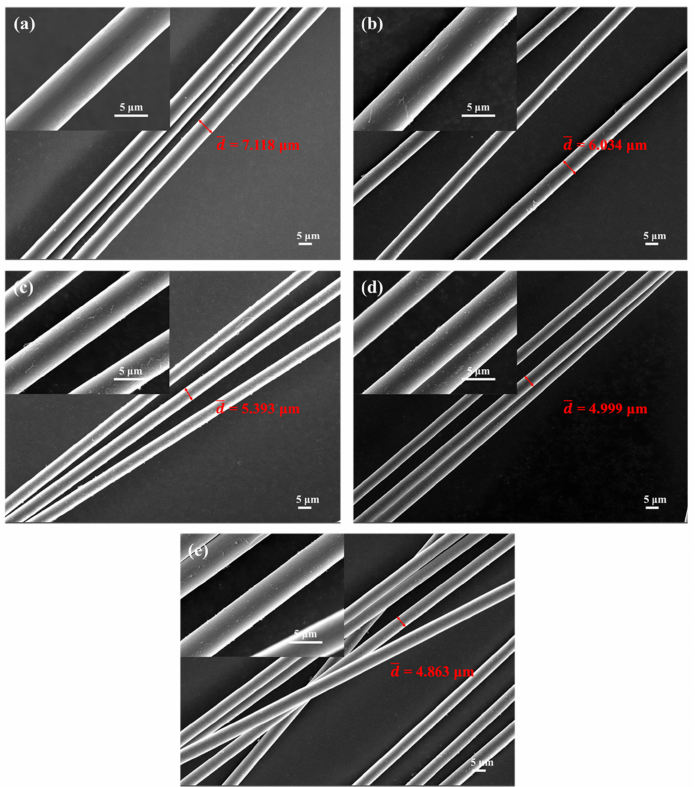
Figure 7. Micromorphology of carbon fibers treated at different temperatures for 15 min: ( a ) room